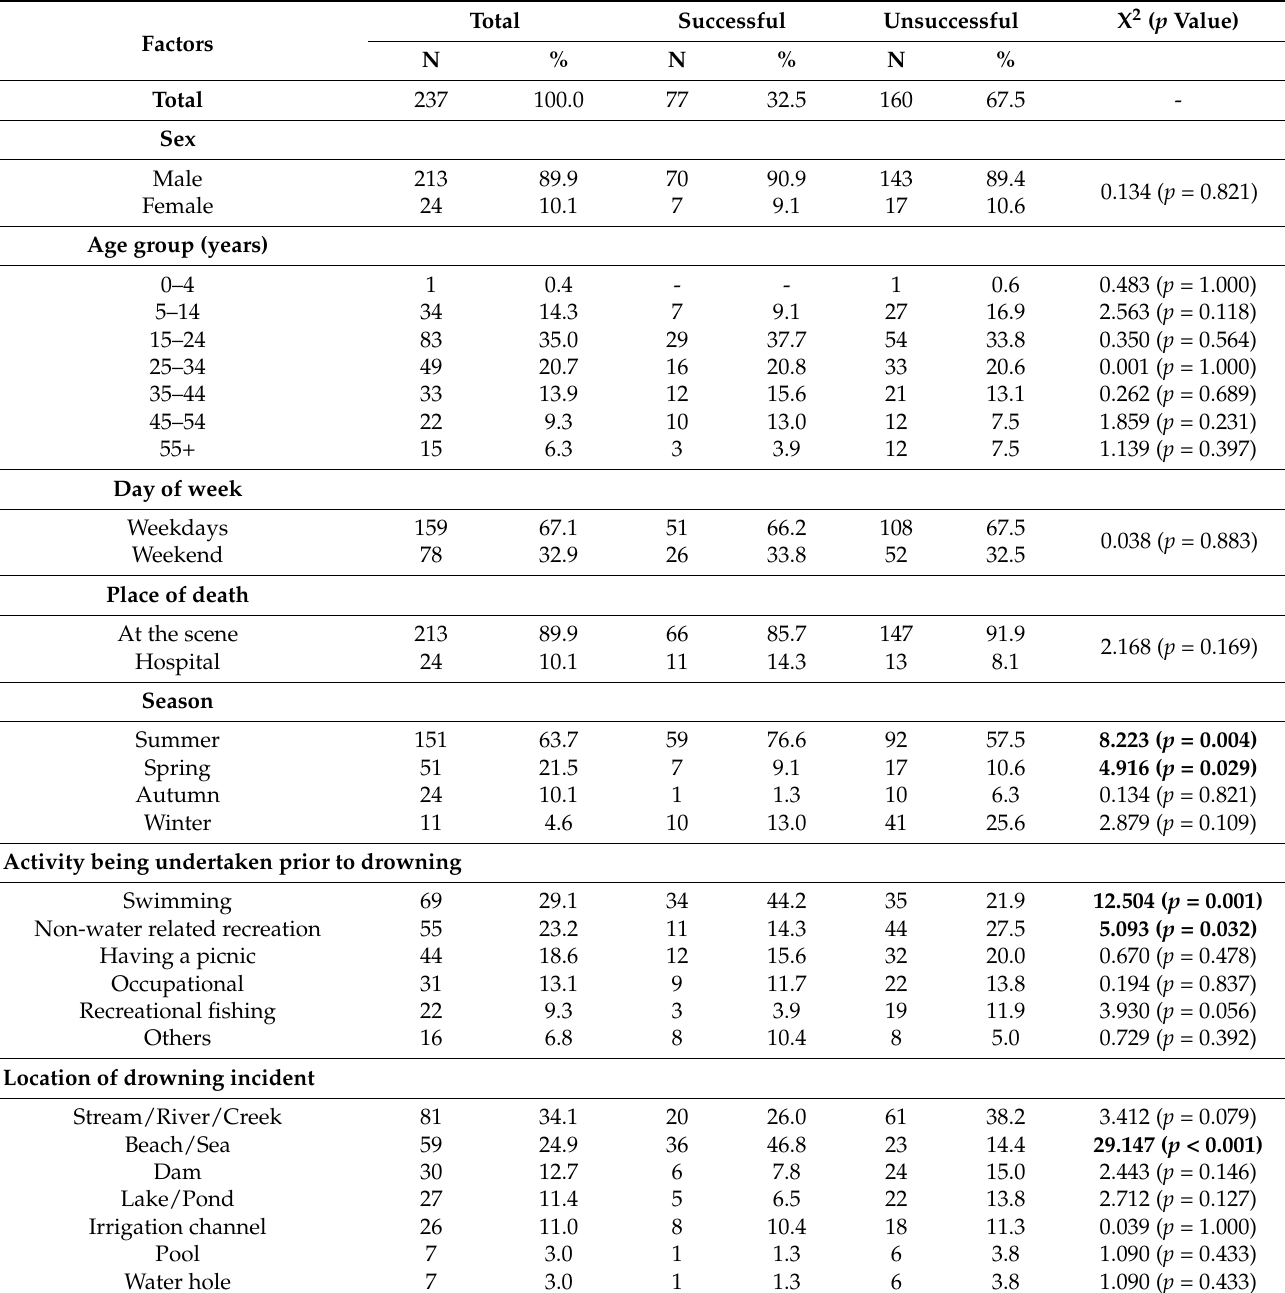
Table 1. Fatal drowning of bystander rescuers by status of rescue attempt, X 2 ( p value); Turkey,